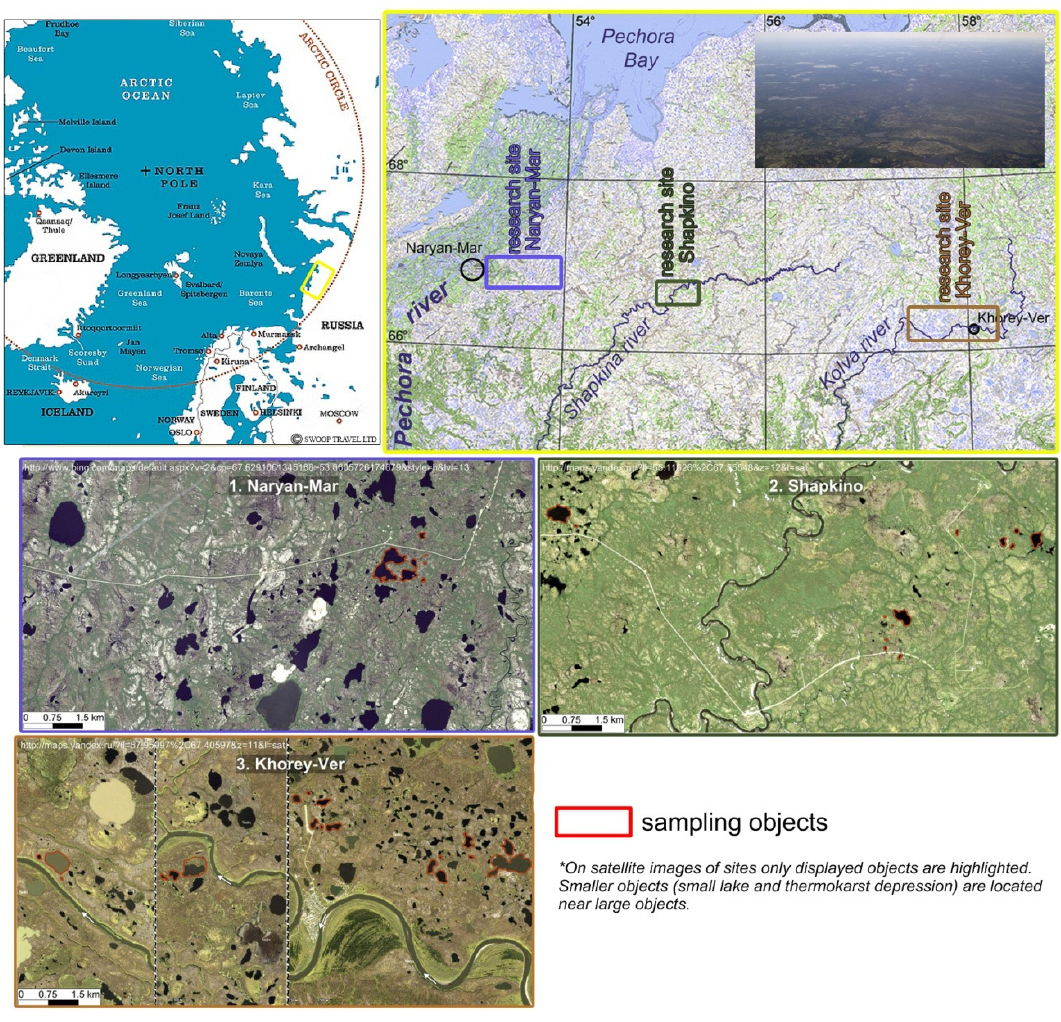
Figure 1. Map of studied sites.